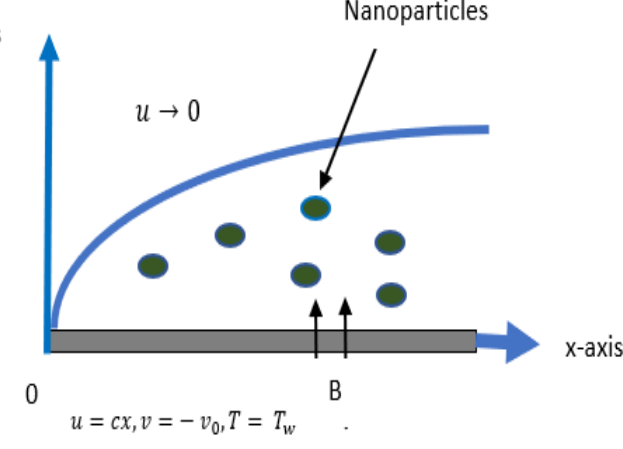
Figure 1. The geometry of the problem.